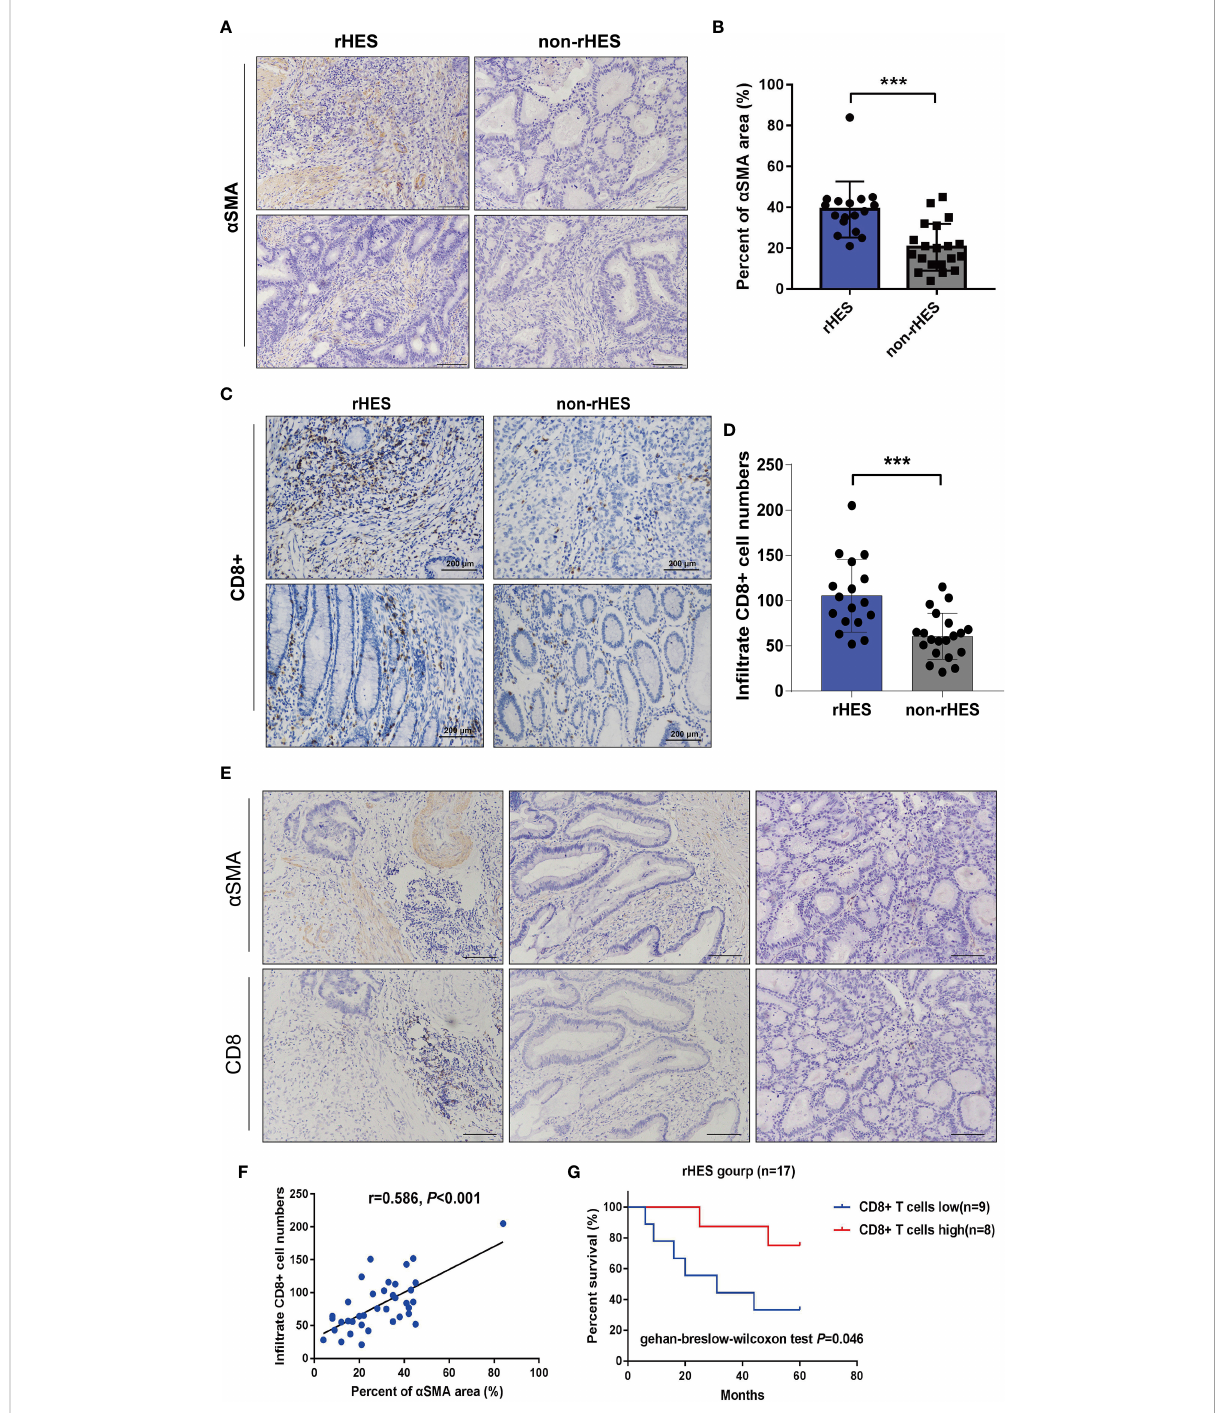
FIGURE 6 Relationship between the expression area of pericytes in the tumor tissue and in fi ltration density of CD8+ T cells in patients with colorectal cancer (CRC). (A, B) Comparison of the peritumoral cell expression areas in CRC patients treated with Endostar intervention. (C, D) Endorsement Intervention in colorectal cancer patients. (E) The correlation between the expression area of pericytes and the in fi ltration density of CD8+ T cells was examined by immunohistochemistry (×200). (F) Analysis of the correlation between the expression area of pericytes and the in fi ltration density of CD8+ T cells. (G) The effect of different CD8+ T-cell in fi ltration densities on the overall survival time of patients receiving Endostar intervention,